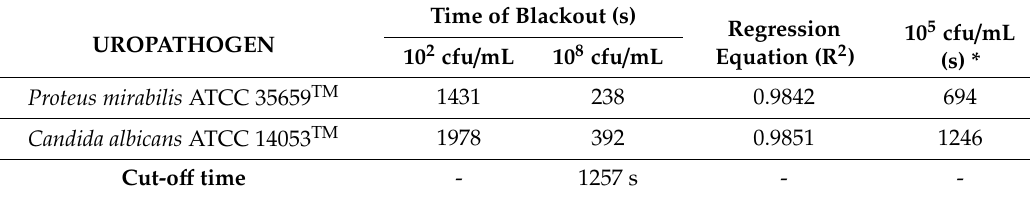
Table 1. Time of blackout for the four standard strains of uropathogens.